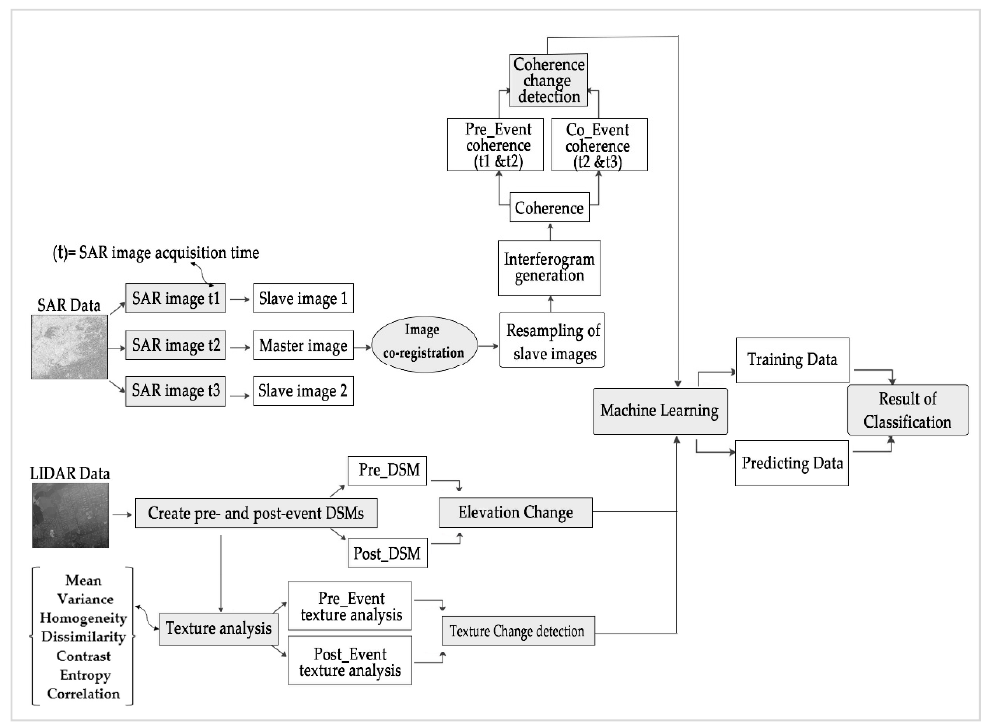
Figure 5. The flowchart of methods used for damage assessment using Machine Learning algorithms.